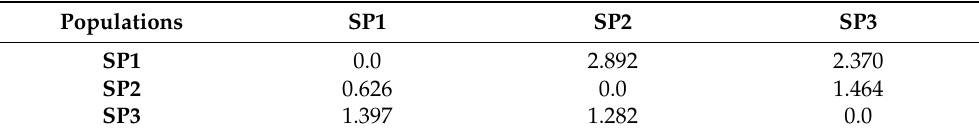
Table 6. Pairwise population matrix of the Nei genetic distance below the diagonal and gene flow above the diagonal of 163 Mithun, 10 gaur, and 25 Tho-tho cattle germplasm at the subpopulation level.